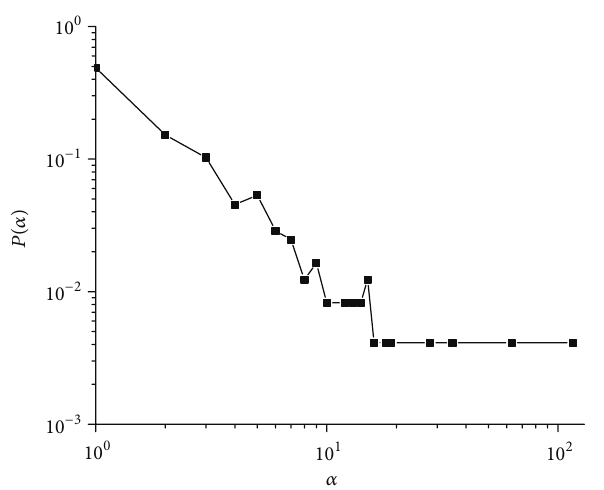
Figure 7: Probability distribution of the dynamic community age 𝛼 .